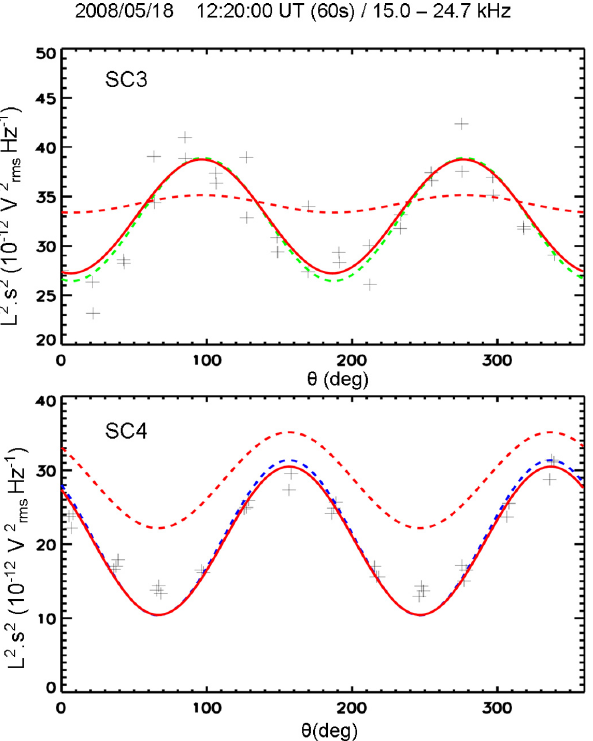
Fig. 4. Electric signal versus antenna attitudes, with C3 data at top and C4 data at bottom (same data set as in Fig. 1). As in Fig. 1, grey crosses are measured samples, the dashed green curve (top) and dashed blue curve (bottom) represent best fits to instantaneous signal variations. Red curves correspond to the modelled electric fields (instantaneous power variations) solution of the DSM tool un- der respectively elliptical polarization assumption (solid lines) and circular polarization assumption (dashed